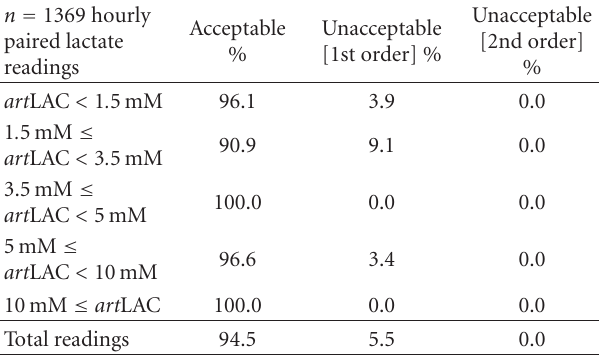
Table 4: Clinical evaluation of absolute subcutaneous adipose tis- sue versus arterial blood ( art LAC) lactate concentrations stratified for individual lactate ranges after 6-hour one-point calibration.